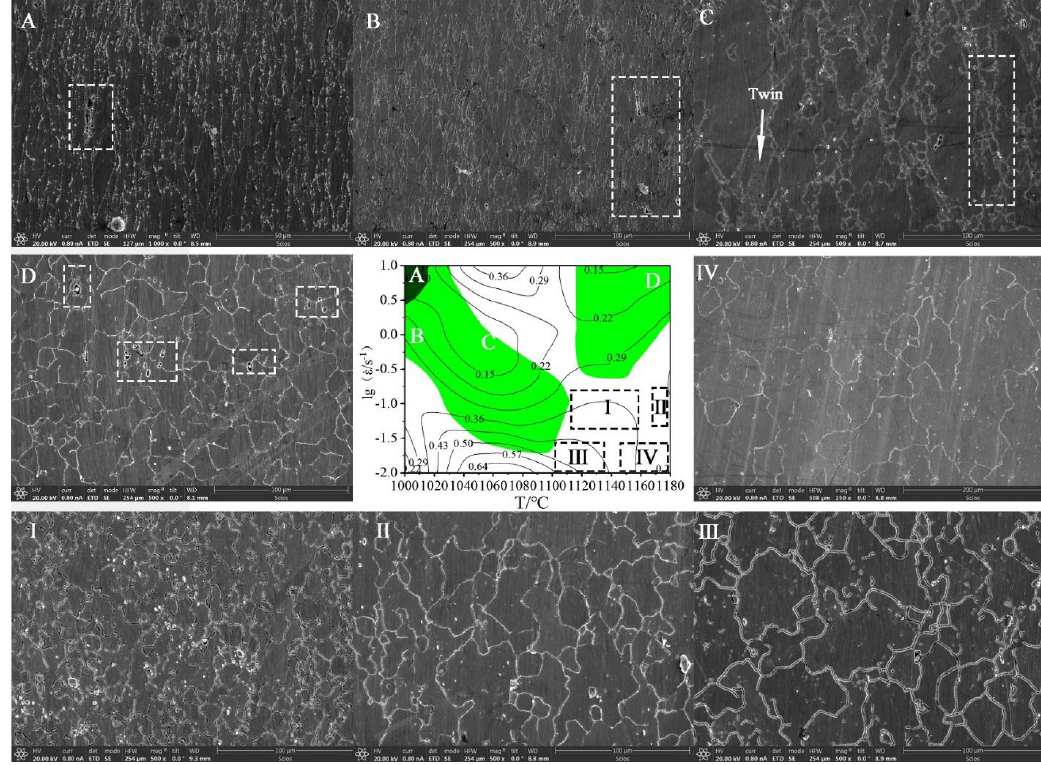
Figure 11. ANN processing map microstructure of di ff erent regions: ( A – D , I – IV ) are the microstructures under the corresponding processing